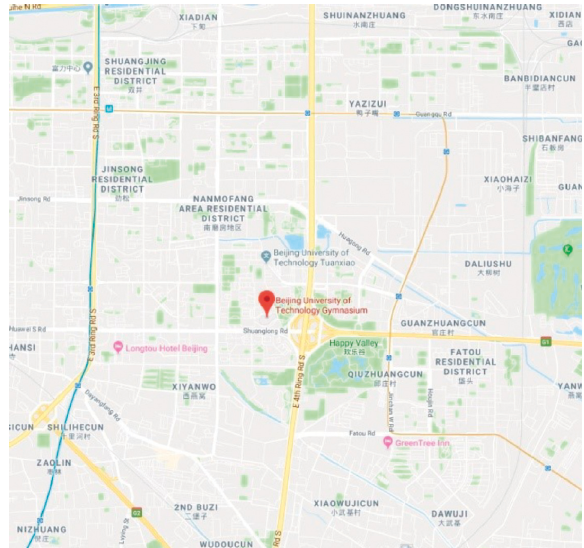
Figure 2: PM 2.5 monitoring